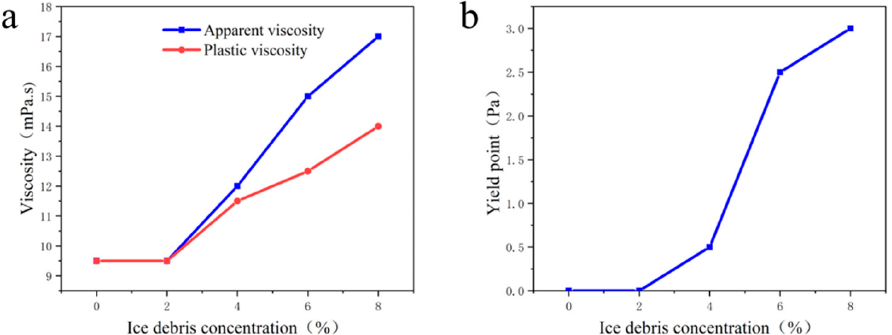
Figure 2. Influence of ice debris concentration on the rheological properties of drilling fluid; ( a ) vis- cosity; ( b ) yield point.